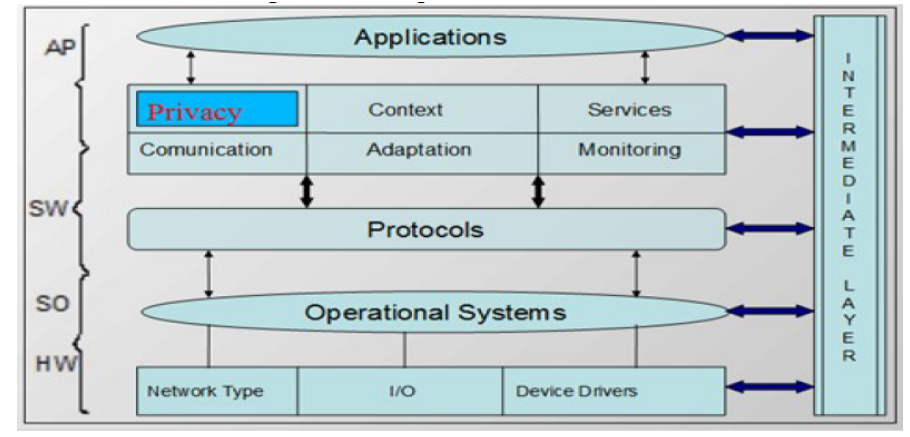
Figure 4. UbiPri Architecture